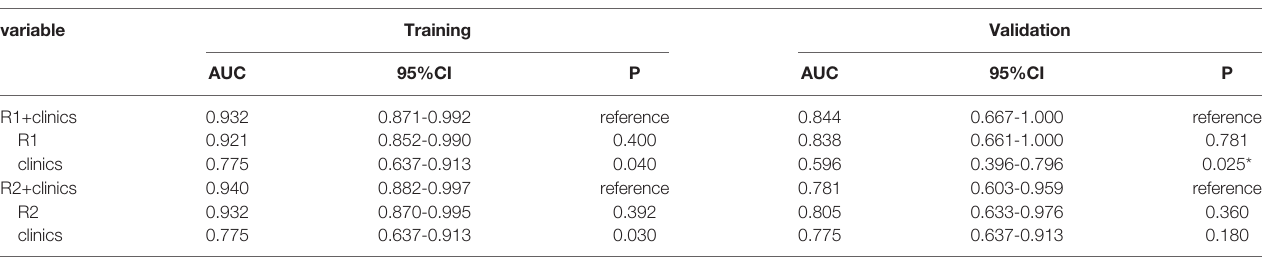
TABLE 6 | The AUC of selective clinical model compared to radiomics model.